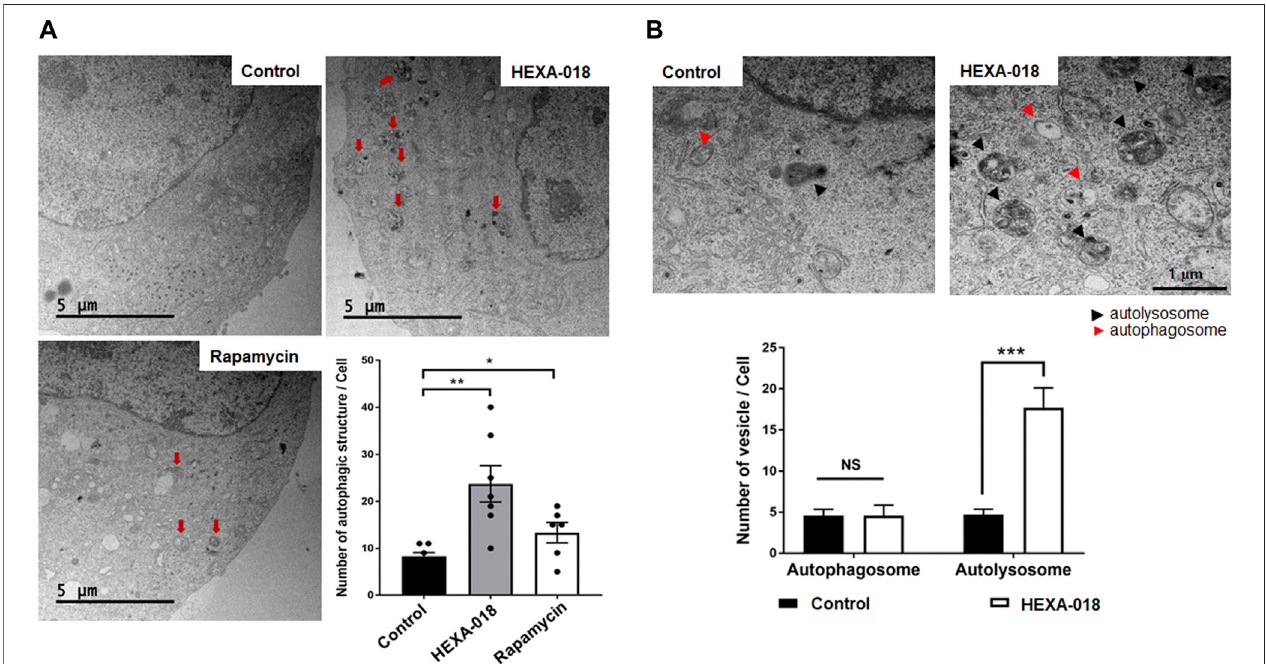
FIGURE3| HEXA-018increasestheformationofautolysosomesinneuronalcells. (A) RepresentativeTEMimagesshowingautophagyinN2acellsandHexa-018- or rapamycin-treated cells. N2a cells were treated with HEXA-018 (5 µM) for 24 h and then analyzed. Rapamycin (200 nM) was used as a positive control. Electron microscopy images show that the number of autophagic structures and vesicles was signi fi cantly increased by HEXA-018 in N2a cells. The red arrows indicate autophagic structures. Quanti fi cation of the number of autophagic structures and vesicles per cell. * p < 0.05; ** p < 0.005 (one-way ANOVA with Tukey ’ s multiple comparisontest). (B) Thearrowheadsindicateautophagosomes(red)andautolysosomes(black).Quanti fi cationofthenumberofautophagosomesandautolysosomes from the images ( n (cid:2) 7) is shown in the graph. The bar graph shows the mean ± SEM of the representative groups. *** p < 0.001; n. s. , not signi fi cant (one-way ANOVA with Tukey ’ s multiple comparison